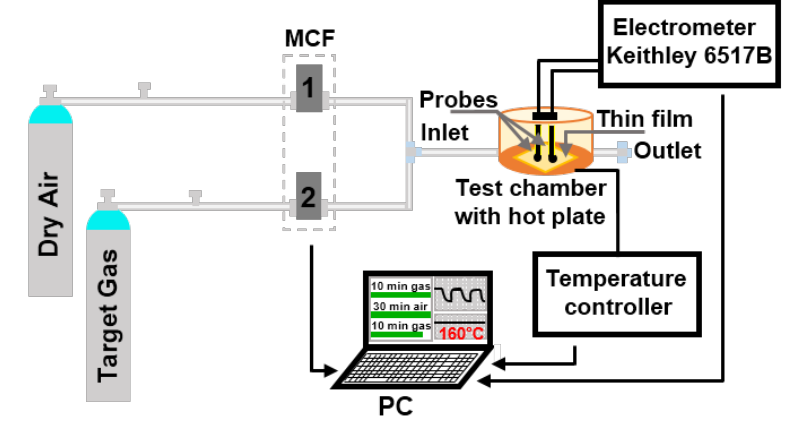
Figure 1. Schematic view of the gas sensing measurement system.